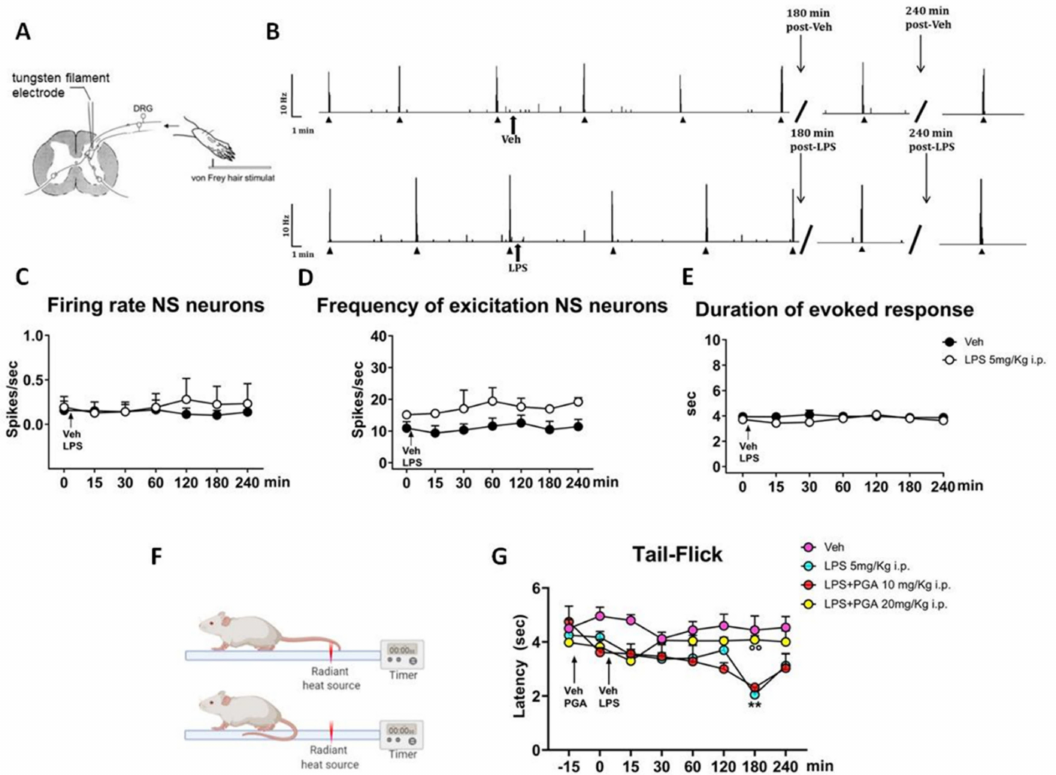
Figure 4. ( A ) Schematic diagram showing recording electrode placement for single-unit in vivo recording of NS neurons in spinal cord L4-L6 segments, after Von Frey stimulation on mouse hind paw. ( B ) Representative ratematers showing spontaneous and noxious-evoked activity of NS neurons recorded pre- and post- intraperitoneal injection of vehicle or LPS. ( C ) Spontaneous activity, ( D ) frequency and ( E ) duration of excitation of the evoked activity of NS neurons, in vehicle or LPS-injected mice. Each point represents the mean ± S.E.M of 3 different mice per group (one neuron recorded per each mouse). Two-way ANOVA for repeated measures followed by Tukey’s post hoc test was used for comparison between groups. ( F ) Representative diagram of tail-Flick test apparatus. ( G ) Effect of PGA (10 and 20 mg/kg), injected 15 min before LPS (5 mg/kg), on tail-flick latency in naïve mice ( N = 5). Values are expressed as mean ± S.E.M. Two-way ANOVA for repeated measures followed by Tukey’s post hoc test was used for comparison between groups. ** p < 0.01 indicates statistical difference vs. Veh and ◦◦ p < 0.01 indicates statistical difference vs. LPS 5